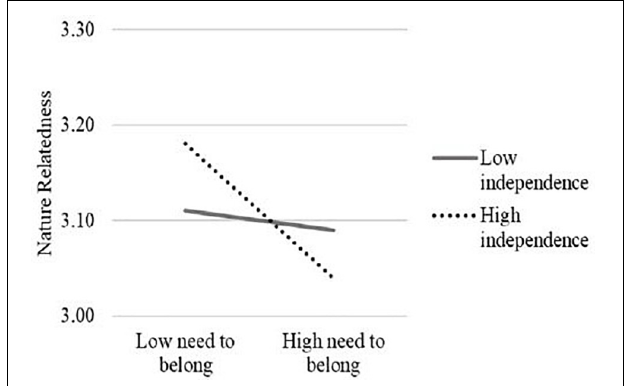
FIGURE 2 | The interaction effect of the need to belong and independence in predicting nature relatedness in Study